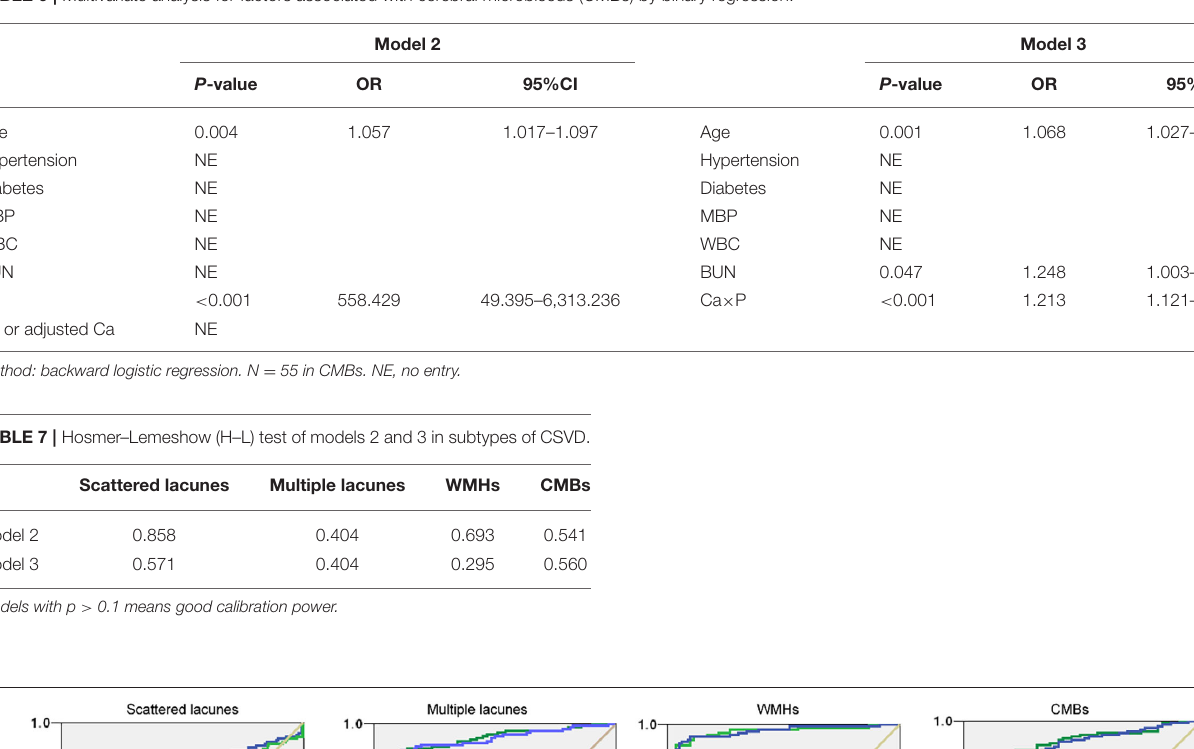
TABLE 6 | Multivariate analysis for factors associated with cerebral microbleeds (CMBs) by binary regression.